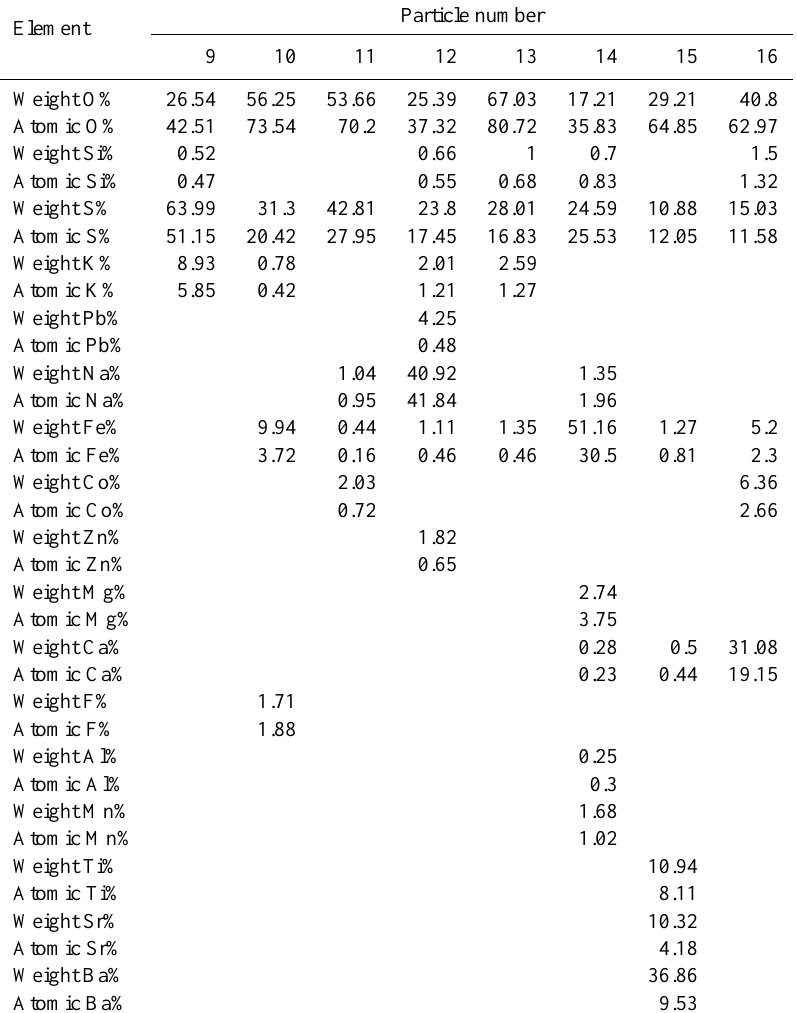
Table 3. EDX results for particles 9–16.